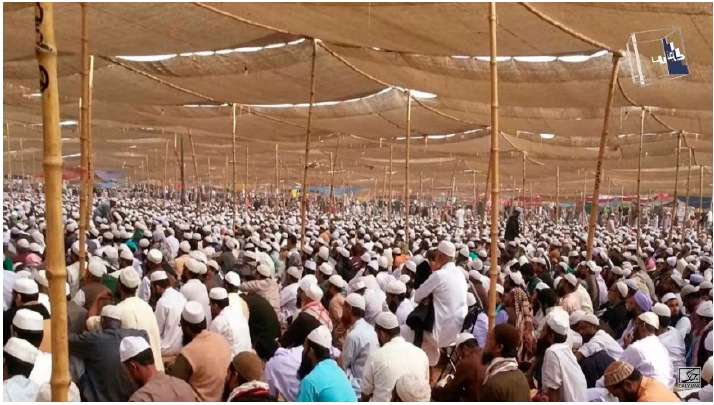
Figure 3. A typical crowd gathered to listen to Maulana Tariq Jamil under makeshift tents. Source: Daily Jang (accessed 8 July 2022).